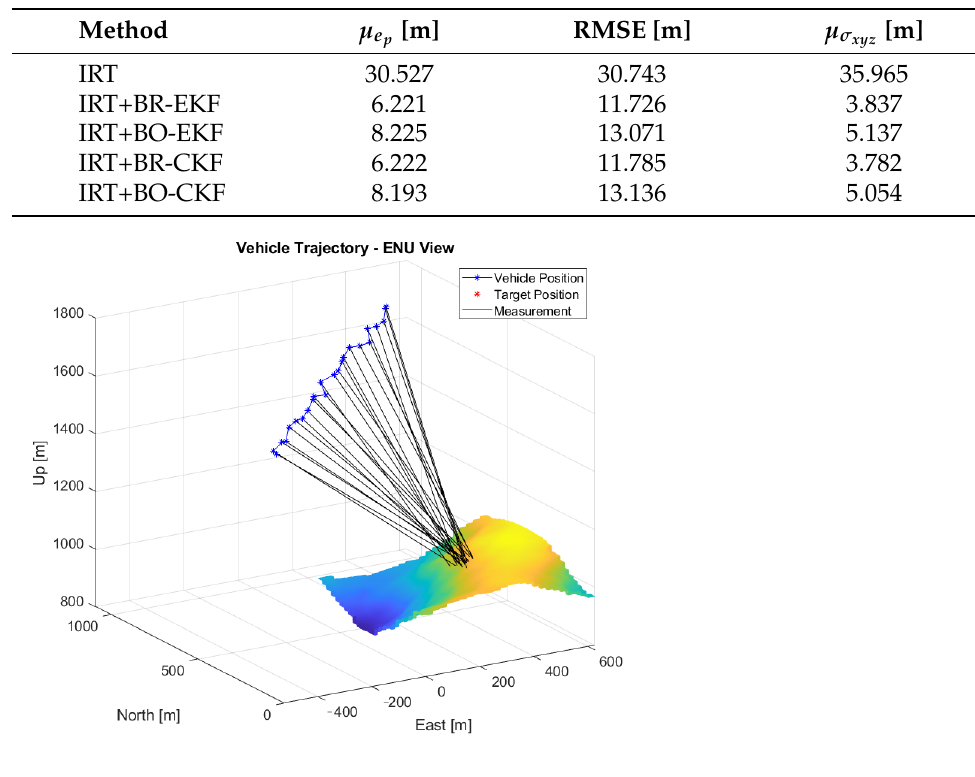
Figure 5. Measurements with noise-induced position and attitude on the rough terrain simulation.